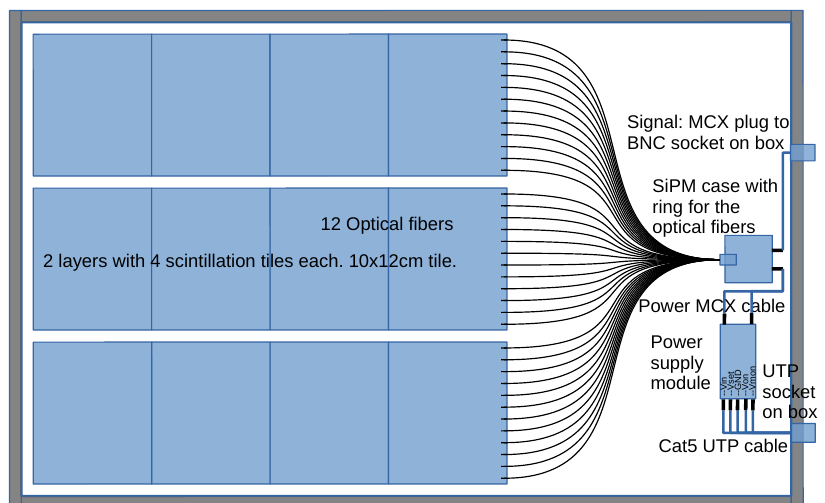
Figure 1. The design schematic on which the construction was based. The scintillation tiles are shown on the left in blue and the optical fibers as black lines. The components on the right are the SiPM with its enclosing case, the fibers’ termination, the power supply module, and the cabling.